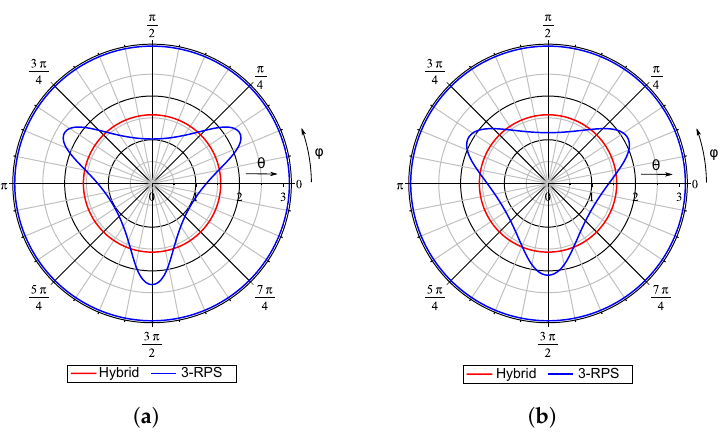
Figure 8. Singularity loci of Hybrid Mechanism 2: ( a ) altitude R = 2 and ( b ) altitude R =